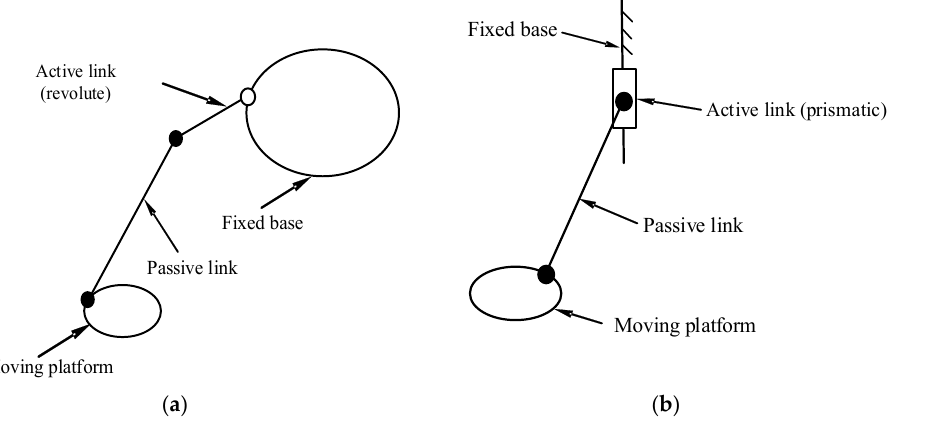
Figure 1. Kinematic chains of parallel manipulators. ( a ) Actuated by revolute joint; ( b ) actuated by prismatic joint.